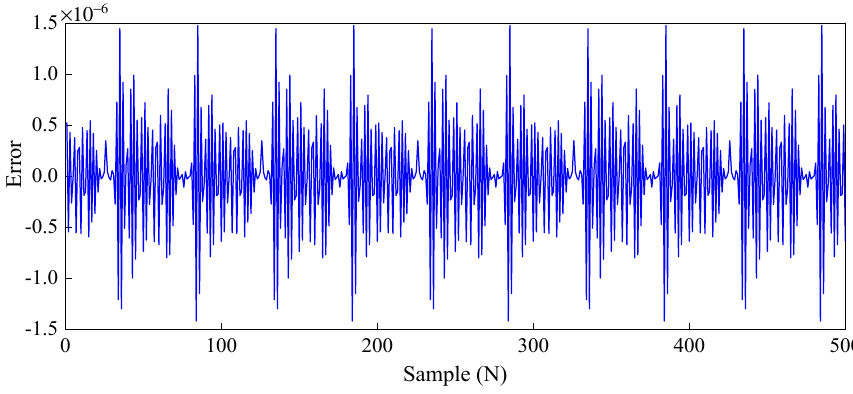
Figure 10. Error of ANFIS inverse dynamics model.